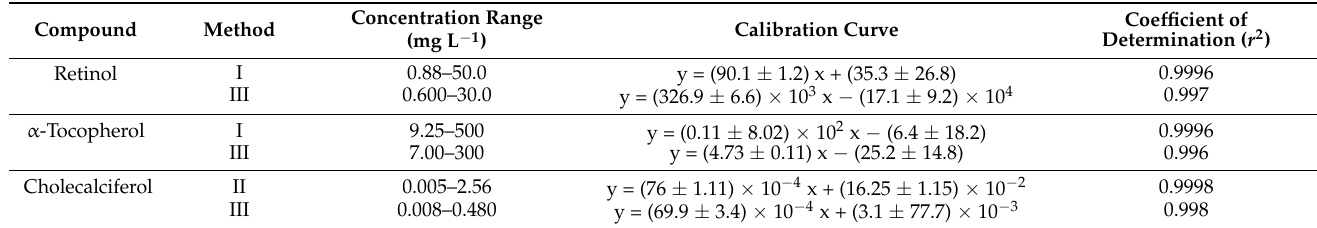
Table 2. Standard calibration curves and correlation factors for each analyte.